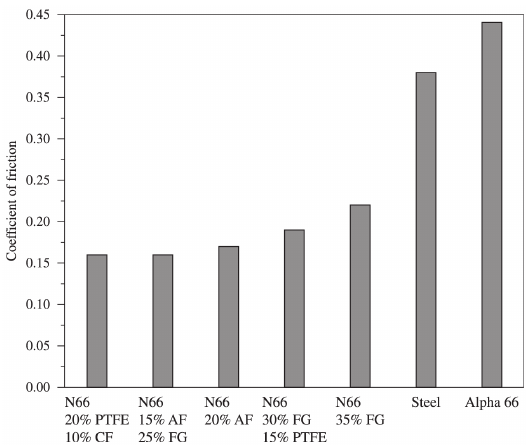
Figure 3. The coefficient of friction for the materials studied.